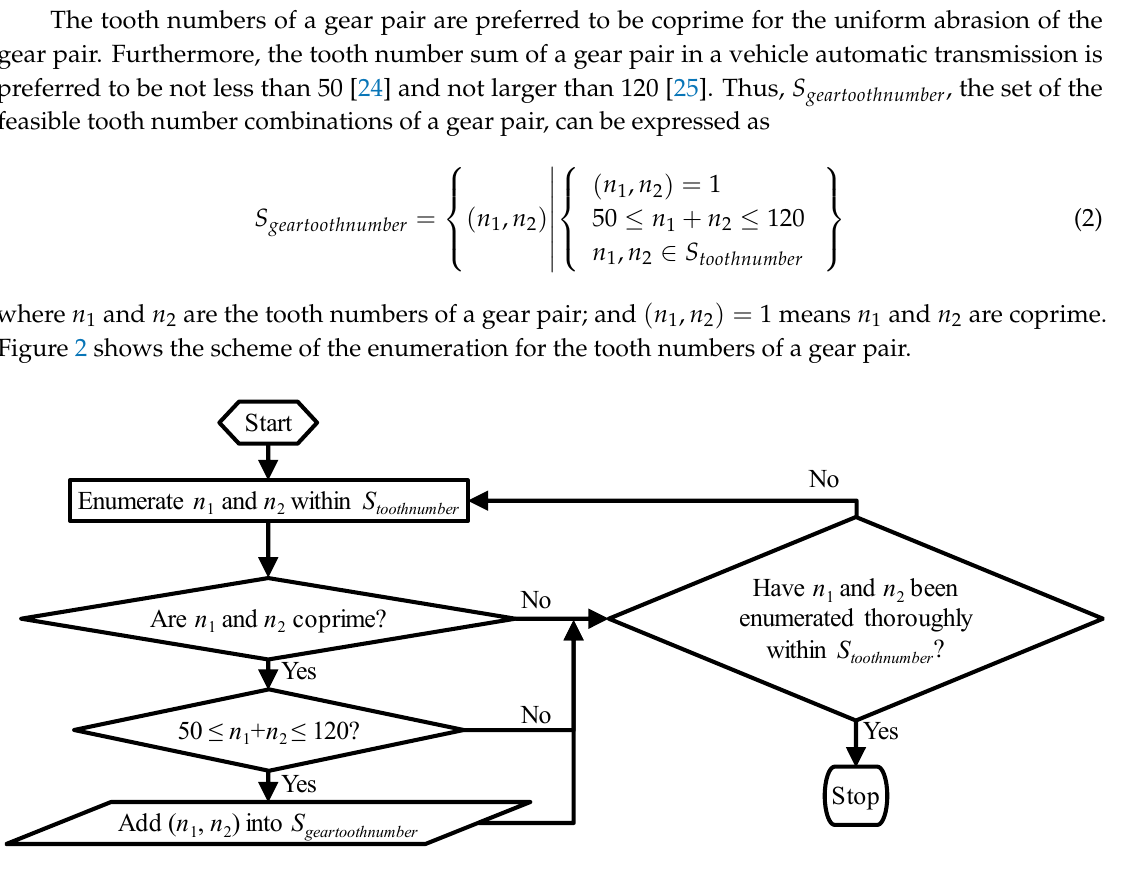
Figure 2. Scheme of the enumeration for the tooth numbers of a gear pair.